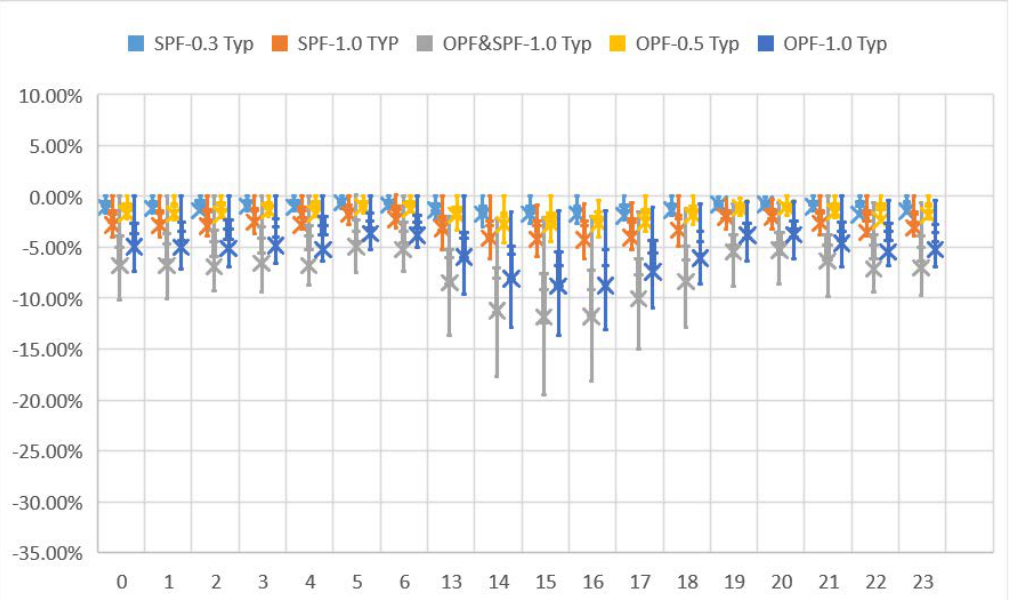
( d ) Box charts for hourly percentage difference in a year for tests for a Typical Floor, (1) Infiltration decreased to 0.3 ach; (2) Infiltration decreased to 0.6 ach; (3) Window-to-Wall Ratio reduced to 14.9%. Appl. Sci. 2020 , 10 , x FOR PEER REVIEW